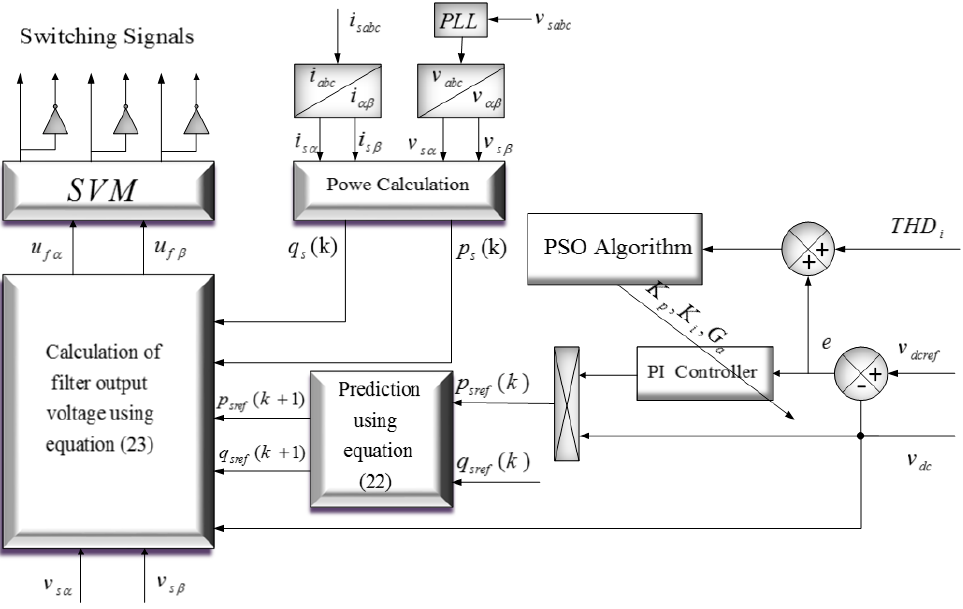
Figure 2. Block diagram of MPPC-SVM approach.